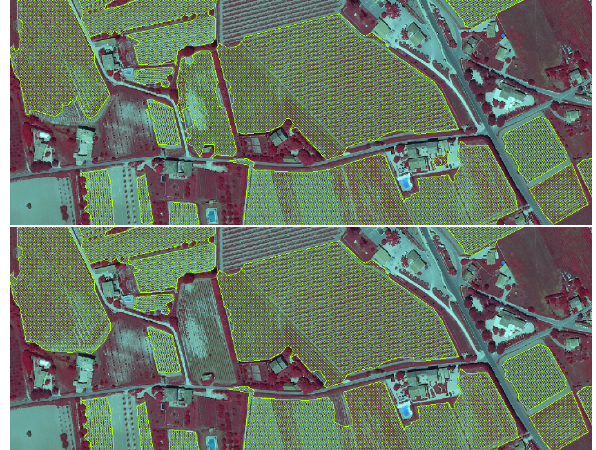
Figure 7: First data set : results of the approaches “frequency analysis” (top) and “classification” (bottom) using per region ML classification algorithm applied to SIFT based texture indexes